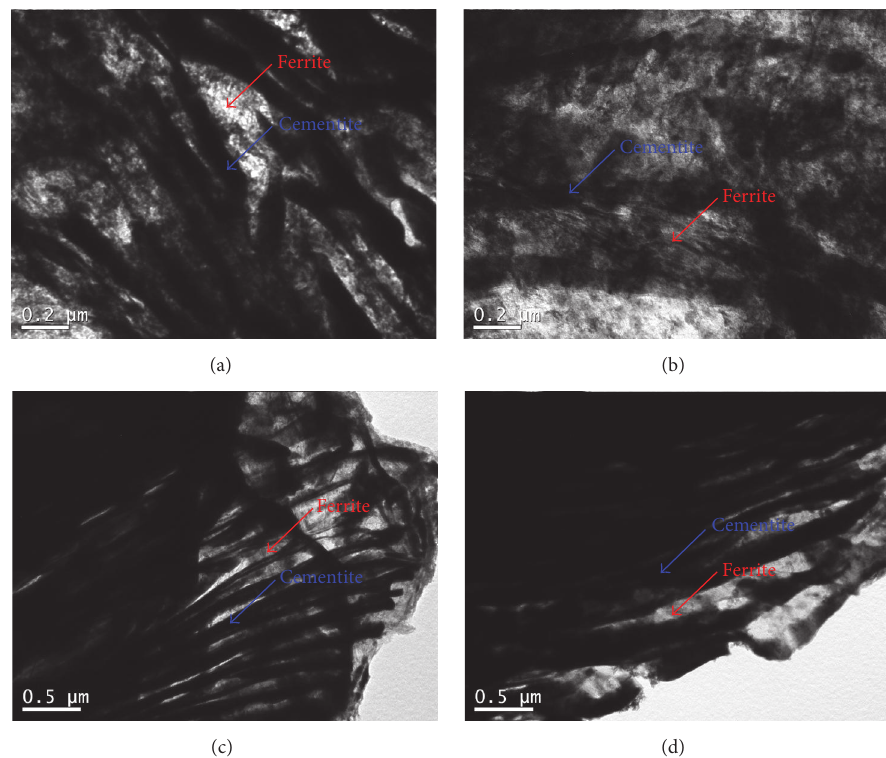
Figure 7: Bright field TEM micrographs of the pearlite in 1045 carbon steel without (a) and with annealing at 873 K (600 ∘ C) for 2 h (b), 4h (c), and 6h (d).